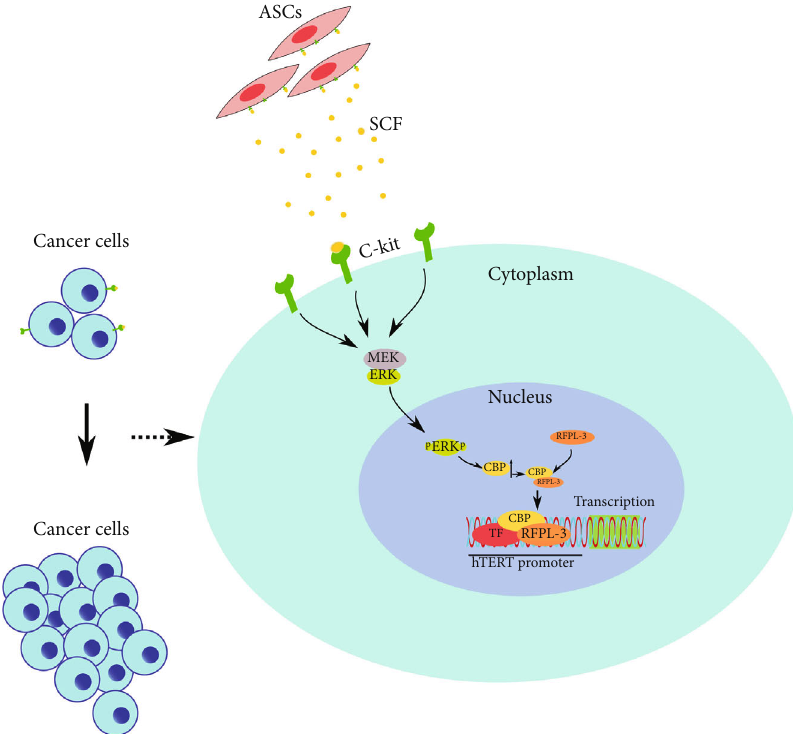
Figure 6: Overview of the proposed pathways for ASCs-induced proliferation of breast cancer